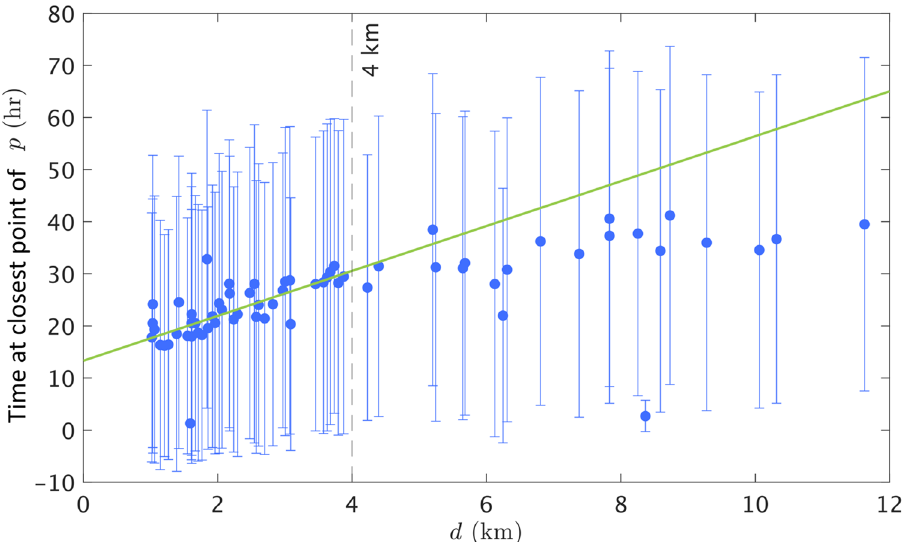
Figure 8. Time at trajectory closest points using p versus d . Circles and error bars show mean and one standard deviation over 500 replicates, respectively. The green line shows the linear fit, t = 4.31 d + 13.31 , for means with d less than 4 km, and its associated effective speed is computed as 0.064 m / s